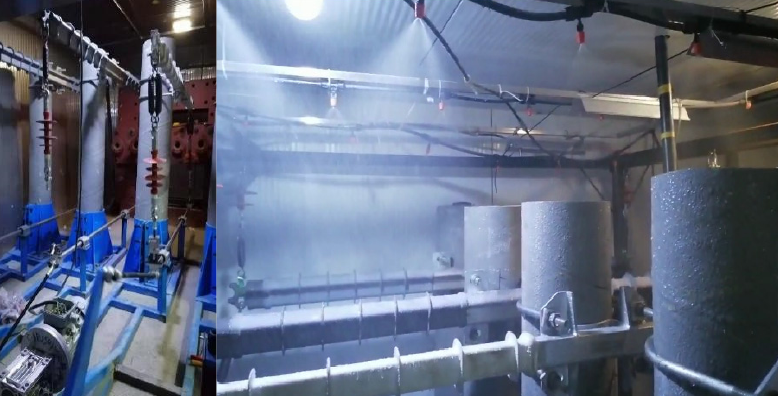
Figure 2. The actual effect diagram of the comprehensive aging system. Table 2. Composite cross arm 5000-h multi-factor aging test cycle program.